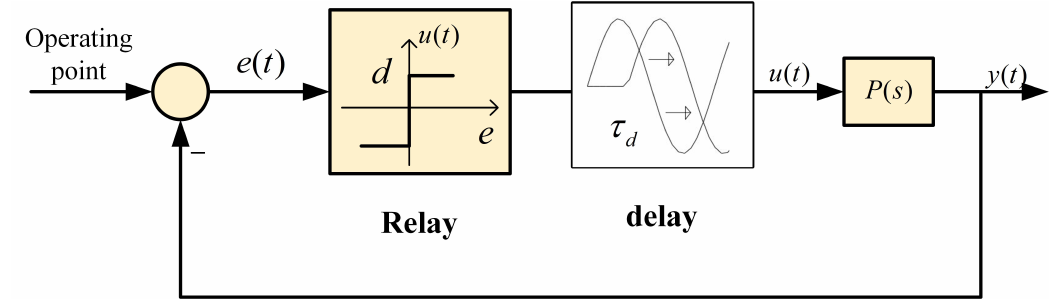
Figure 6. Schematic representation of the relay plus delay